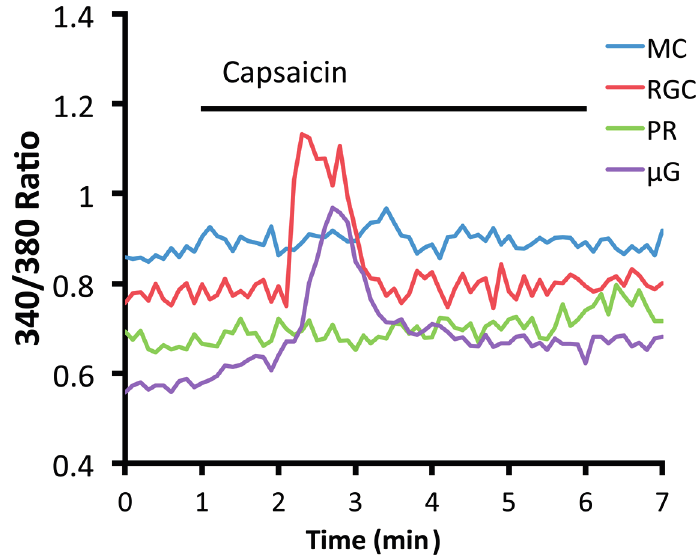
Figure 2. An acutely isolated and dissociated mouse RGC (blue) and microglial cell (µG; green) loaded with fura-2 respond to capsaicin (40 µM) with transient [Ca 2+ ] i elevations that inactivate during stimulus application, whereas a representative photoreceptor (PR; purple) and Müller cell (MC; red) do not respond to the TRPV1 agonist (see [19,103] for